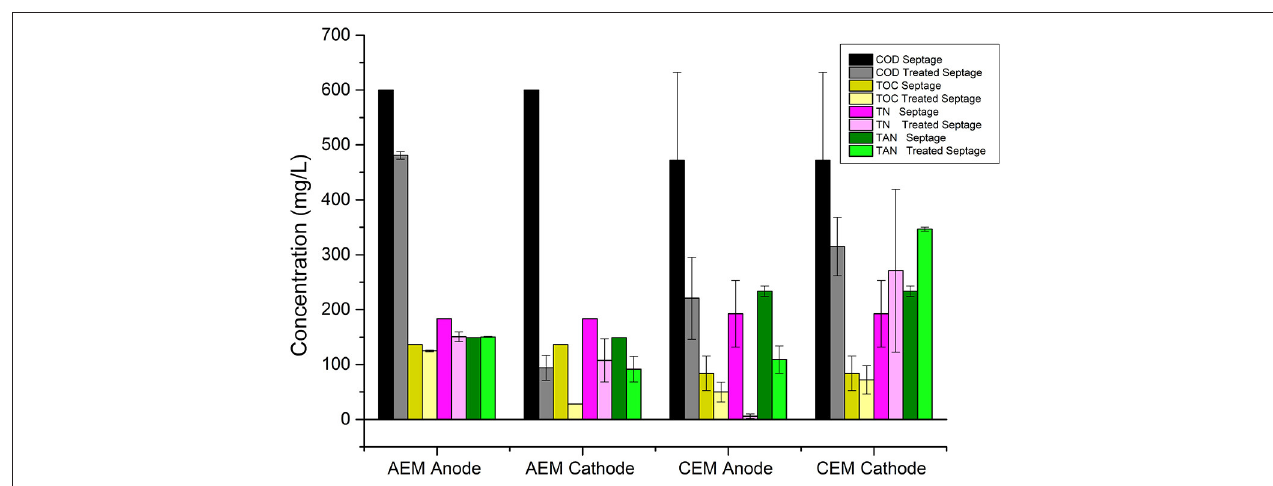
FIGURE 5 | Variation in wastewater parameters of septage/blackwater after 90min of electrolysis in anode and cathode chamber recirculation in ECR with AEM and ECR with CEM.